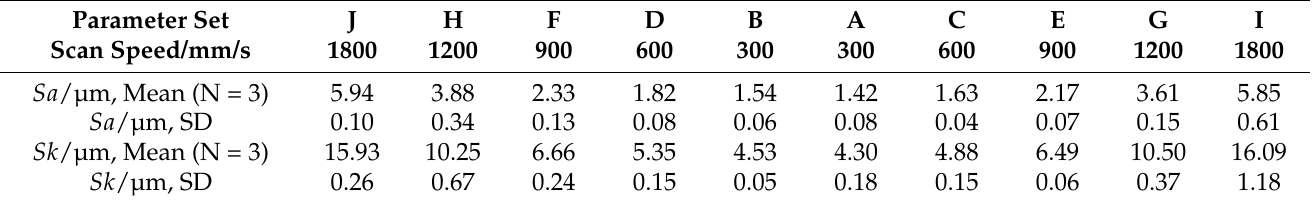
Table A1. Sa and Sk for cuboid samples, 10 surface conditions L-filter 0.25 mm, S-filter 20 µm. With pre-sinter (right), without pre-sinter (left).